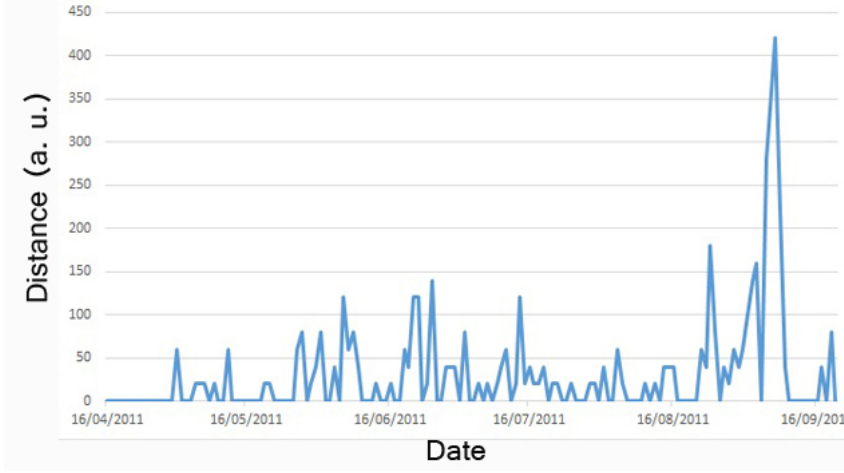
Figure 3. Detection of outliers with the workflow instance acceptor algorithm (WIAA) distance.